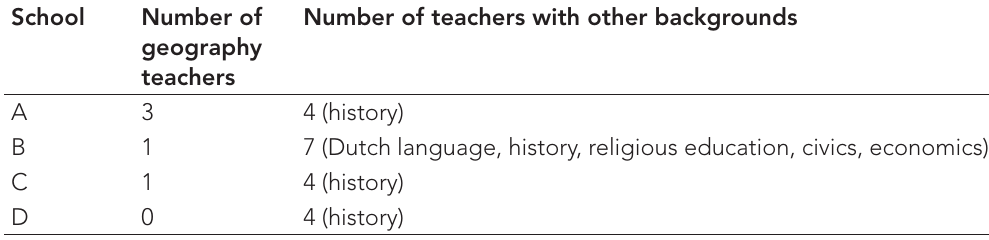
Table 3: Composition of the ‘human and society’ teaching teams at Schools A, B, C and